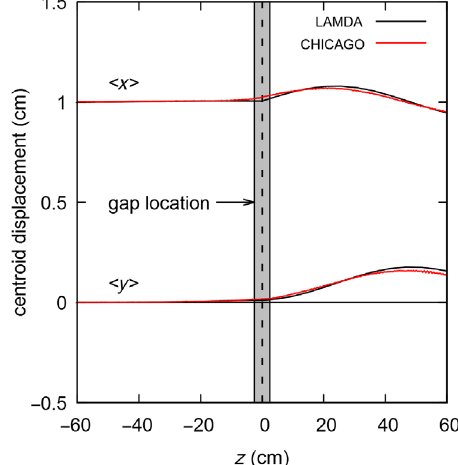
FIG. 5. Centroid displacement as a function of z at t ¼ 30 cm for a beam deflected by a pill-box gap. Results from the beam transport code LAMDA are shown in black and CHICAGO 3D cylindrical simulation results are shown in